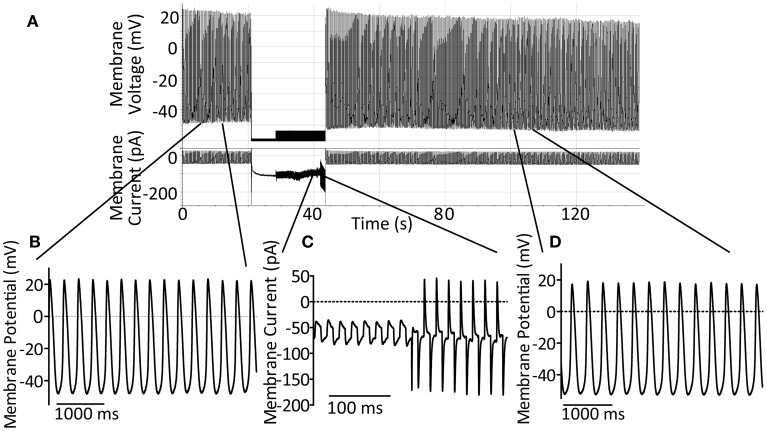
(A) Demonstration of the perforated-to-whole-cell patch method with control patch solution. After formation of a GΩ seal, up to 15 min is allowed for perforation of the membrane (amphorericin B, 240 μg ml−1). Action potentials are recorded in the perforated patch configuration for at least 10 s before switch to voltage clamp at −60 mV using an AxoPatch200B amplifier. Seal integrity can then be monitored and recorded using the amplifier-controlled seal test. Whole-cell access is achieved by rapid suction and confirmed by the onset of large capacitative transients. After gaining whole-cell access the amplifier is rapidly switched back to current clamp mode in order to follow spontaneous action potential firing once again. (B) An expanded section of trace, as indicated, to demonstrate control action potentials in the perforated patch configuration. (C) An expanded section of trace, as indicated, to demonstrate the seal test signal during patch rupture to achieve whole-cell access. (D) An expanded section of trace, as indicated, to demonstrate the maintenance of spontaneous action potential firing and expected action potential shape 60 s after patch rupture under control conditions.